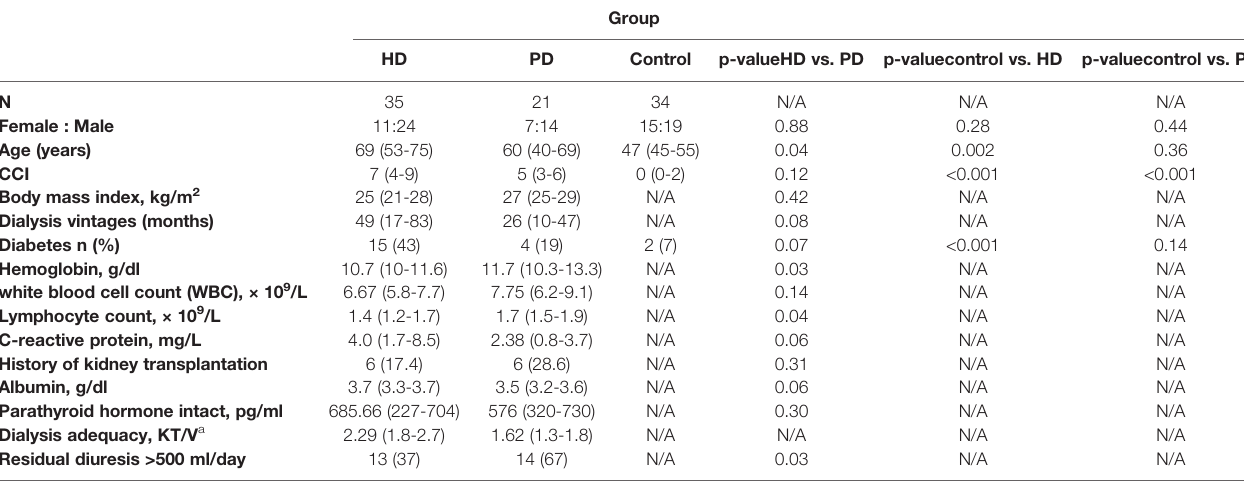
TABLE 1 | Clinical characteristics of peritoneal dialysis (PD), hemodialysis (HD), and control groups.